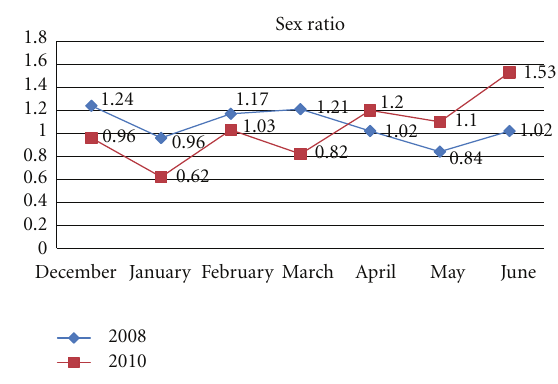
Figure 1: Sex ratio trends using the chi-squared test P = 0 .